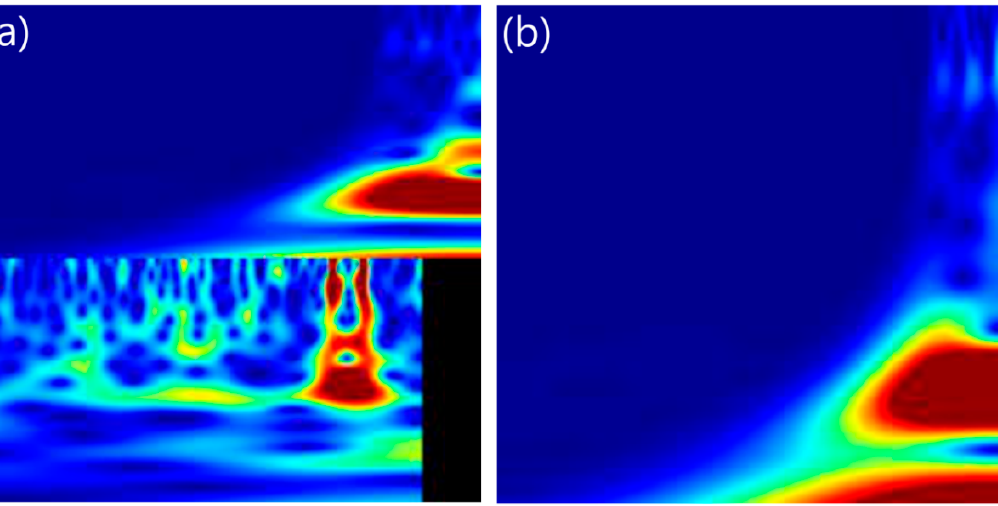
Figure 4. Schema of the use of input time series (TS) for the CNN training and operation for a com- putation time t (cid:2913) : ( a ) training with both rainfall and velocity data, where velocity data are used for both scalogram computation and trend labeling; ( b ) corresponding operation, where weather fore- casts are also used; ( c ) training with rainfall data only, where velocity data are used for trend label- ing only; ( d ) corresponding operation.